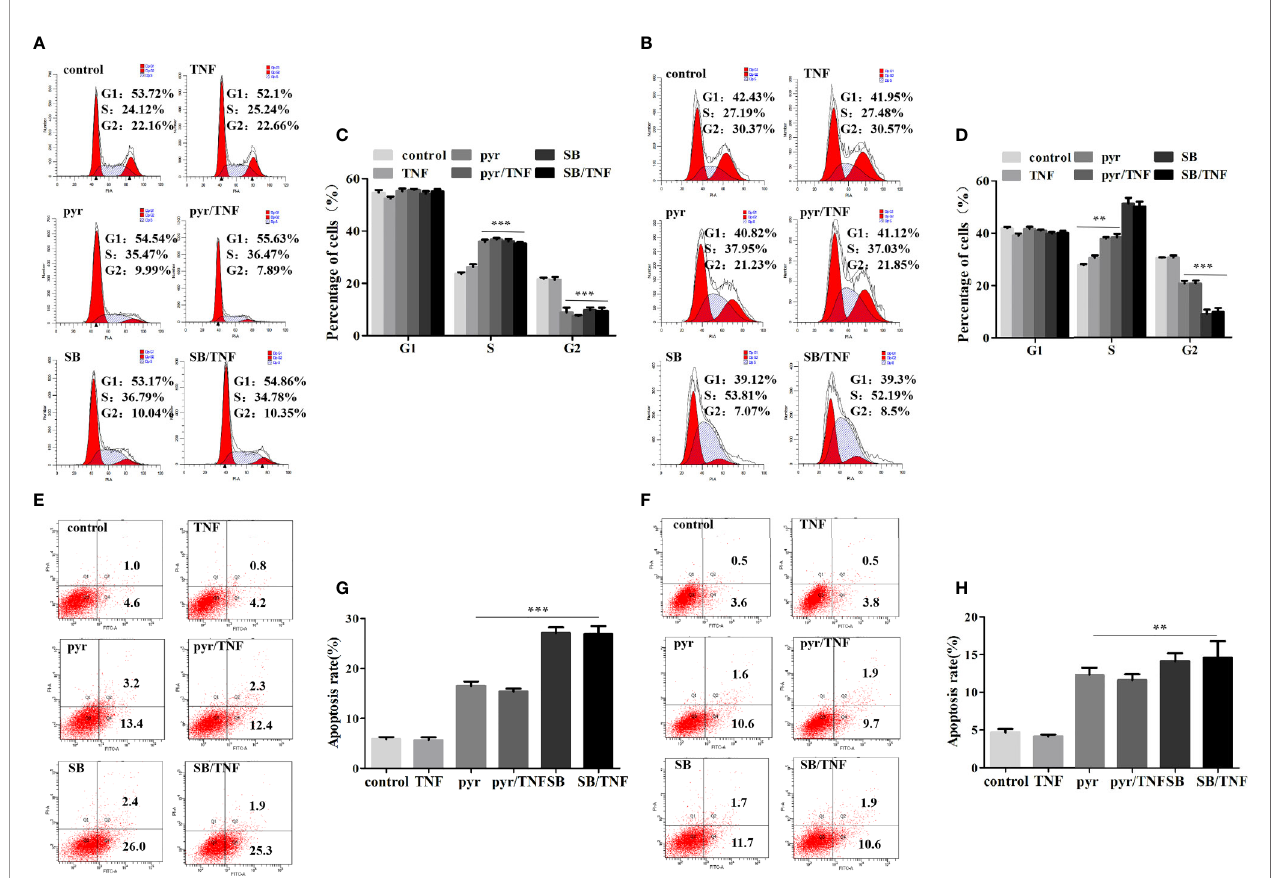
FIGURE 5 | Pyrimethamine inhibits proliferation and promotes apoptosis in CRPC cells through the inhibition of p38 MAPK. (A, B) DU145 and PC3 cells were treated with pyrimethamine or SB202190 (10 m M) for 24 h and then incubated with TNF-a (10 ng/ml) for 24 h, and quanti fi cation of percentages in cell cycle phases was analyzed by fl ow cytometry. (C, D) Mean percentage of cells ± SD was shown (DU145 and PC3). **:P < 0.01; ***:P < 0.001. (E, F) The apoptosis of the treated DU145 and PC3 cells was detected by fl ow cytometry. (G, H) The graph shows the statistical results obtained from three independent experiments. **:P < 0.01; ***:P <